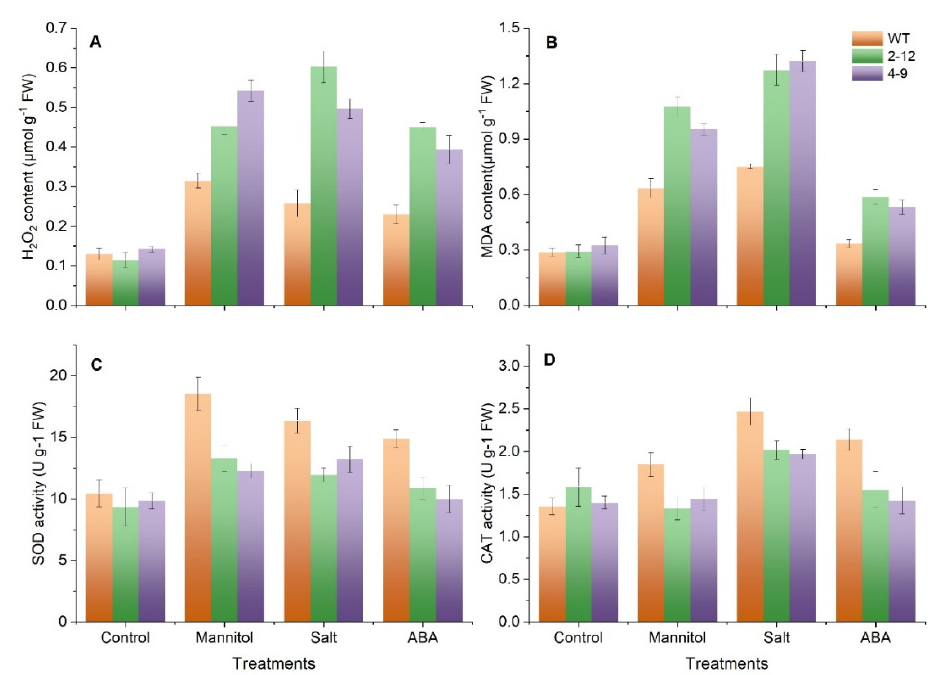
Figure 8. SlBAG9 overexpression aggravated oxidative damage in Arabidopsis under mannitol, NaCl, and ABA treatment. The seven-day-old Arabidopsis plantlets of wild-type, 2–12, and 4–9 were transferred to 1/2 MS containing 0, 300 mM mannitol, 175 mM NaCl, and 1.5 µM ABA for three days for physiological change evaluation. The H 2 O 2 content ( A ), MDA content ( B ), SOD activity ( C ), and CAT activity ( D ) were analyzed quantitatively in WT and SlBAG9-overexpressing lines 2–12 and 4–9. Error bars indicate the SD of three independent experiments.